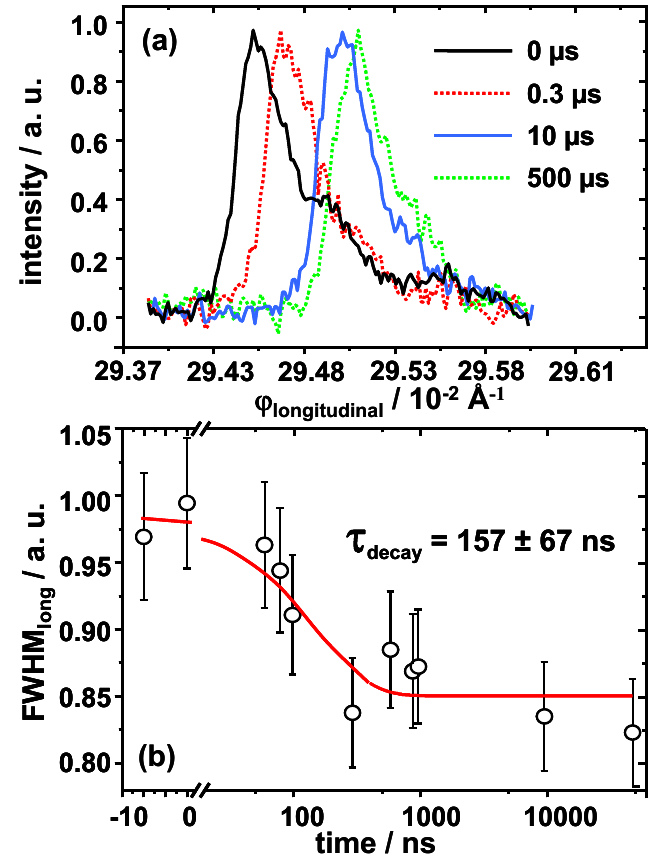
as a function of time. The decay is well fitted with a mono-exponential decay for ϕ longitudinal with a lifetime of 157